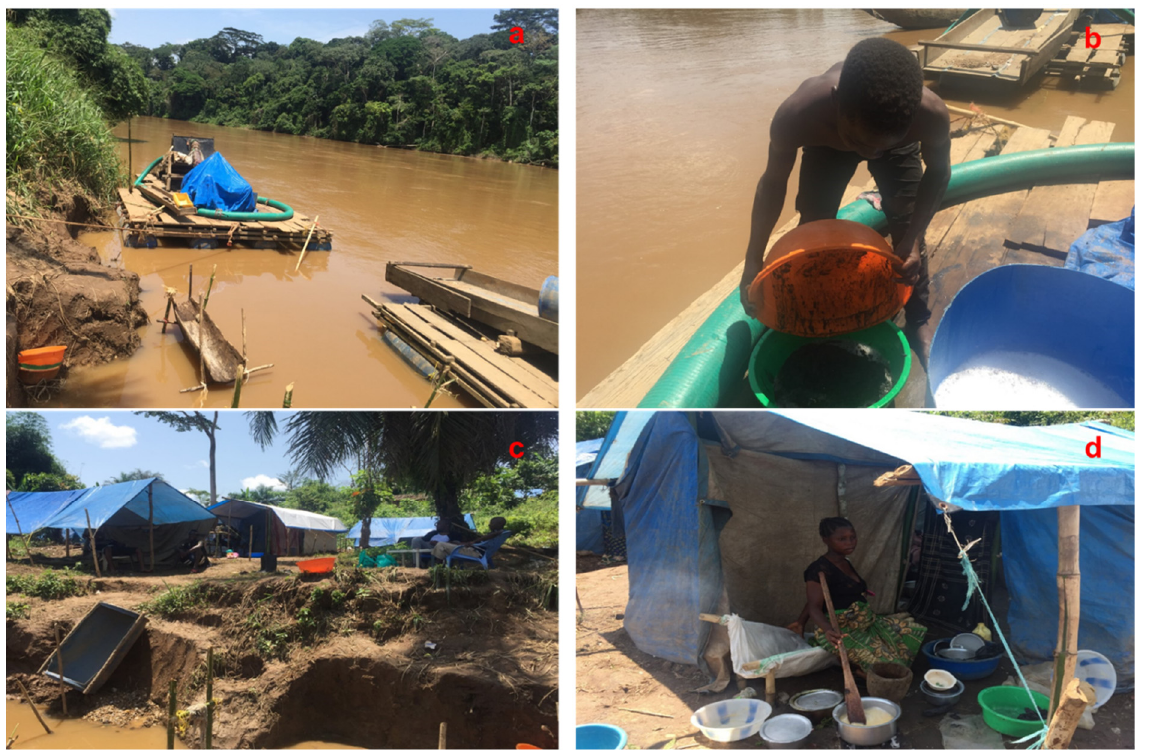
Figure 2. Artisanal and small-scale mining activities and miner’s settlements along the Ulindi River. ( a ): dredge used for gold mining, ( b ): addition of Hg to form the amalgam with gold, ( c ): miner dwellings, ( d ): food cooking on the river bank (Photos by E. Atibu).